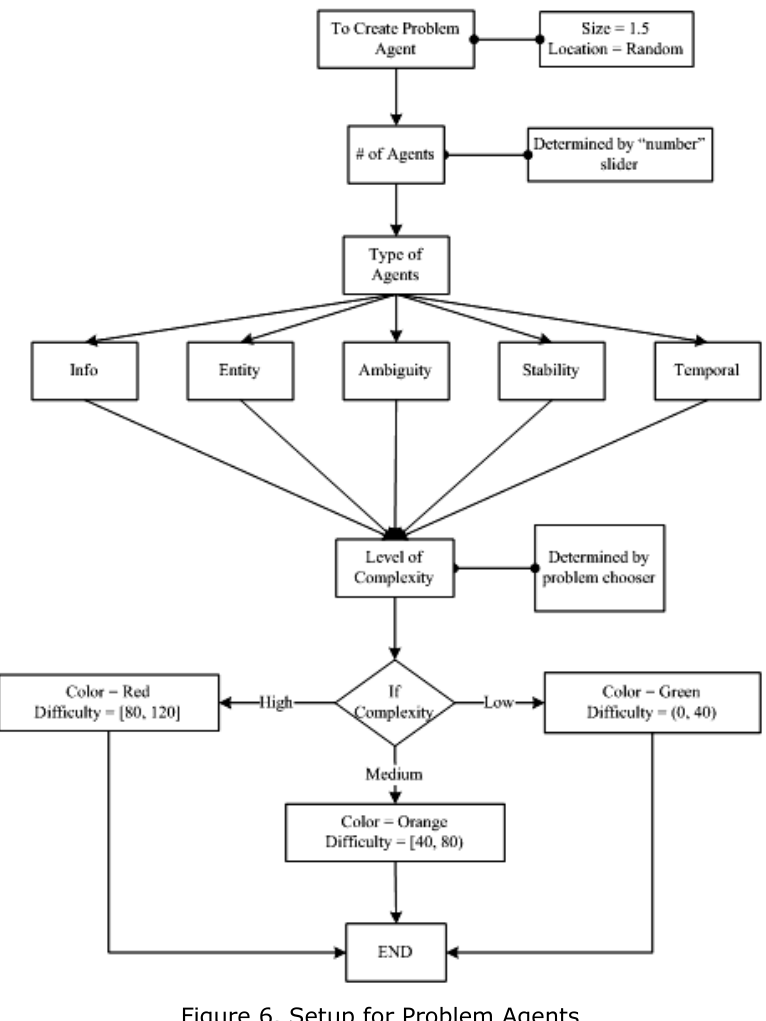
Figure 6. Setup for Problem